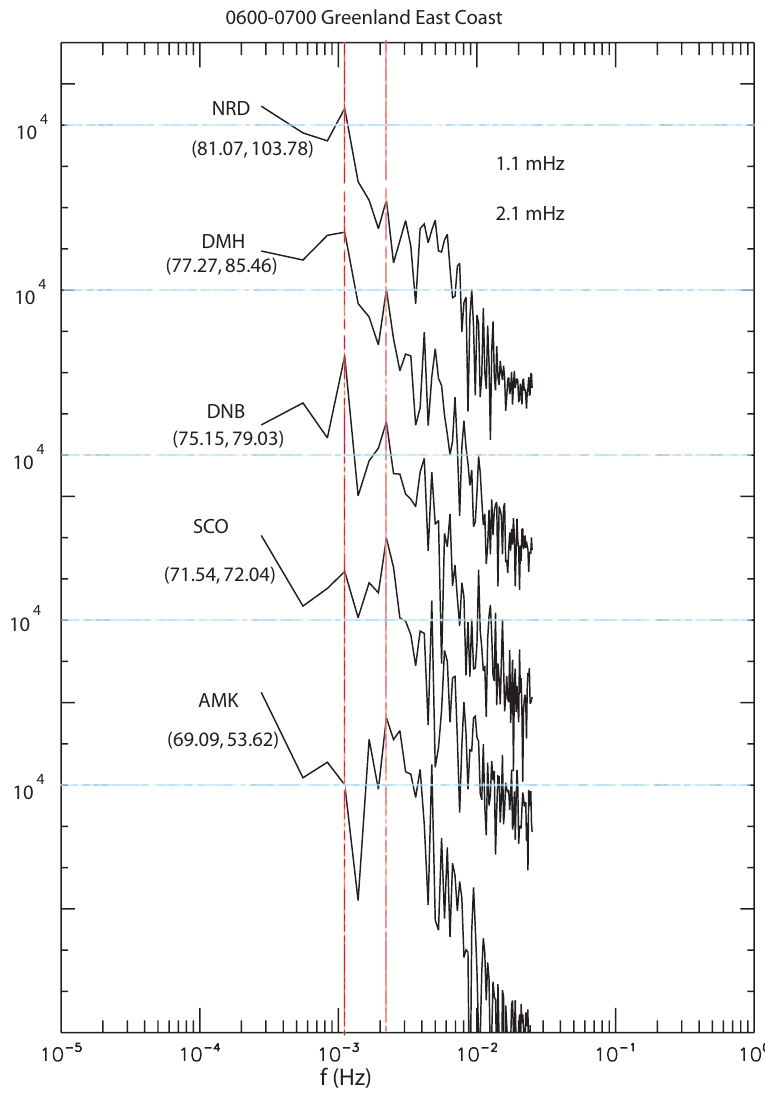
Fig. 10. The power spectra for stations in Greenland’s east coast.